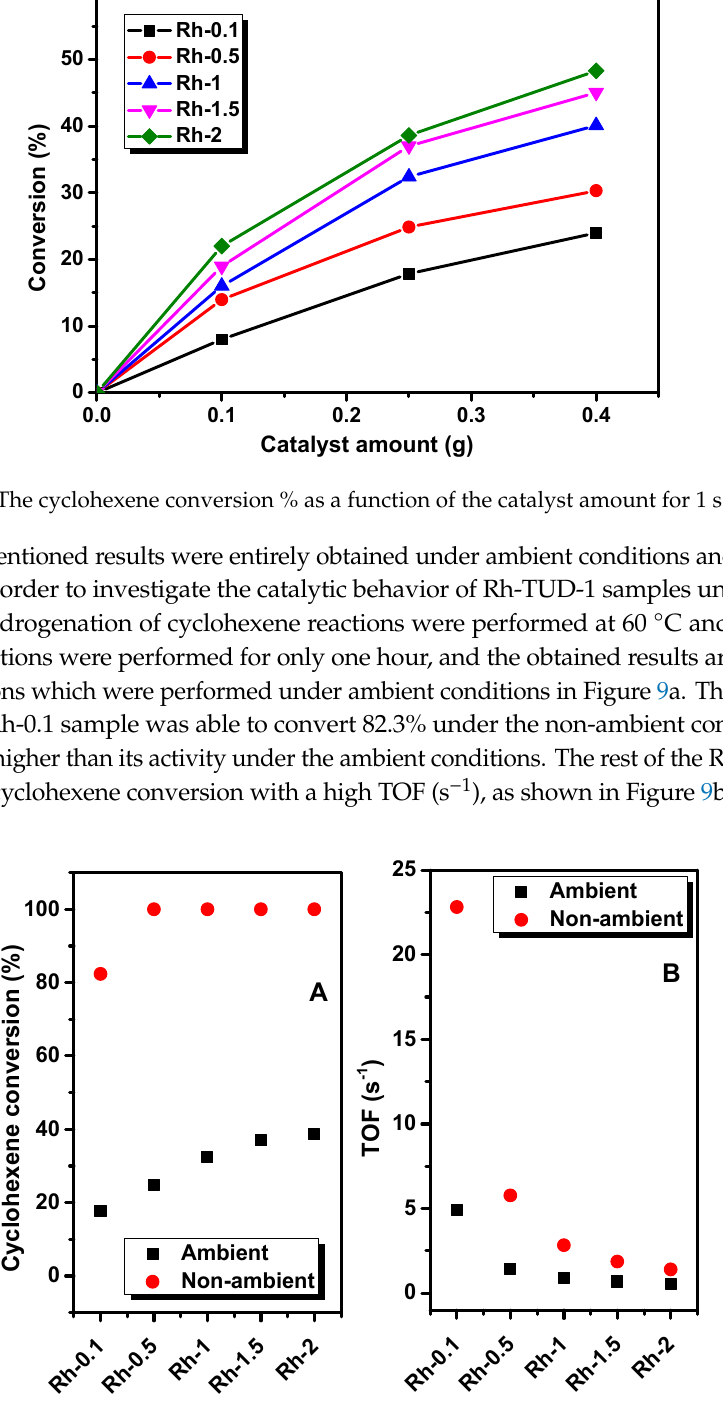
Figure 9. ( A ) A comparison between the catalytic acidity of the Rh-TUD-1 under ambient and non-ambient conditions. ( B ) The corresponding TOF (s − 1 ).